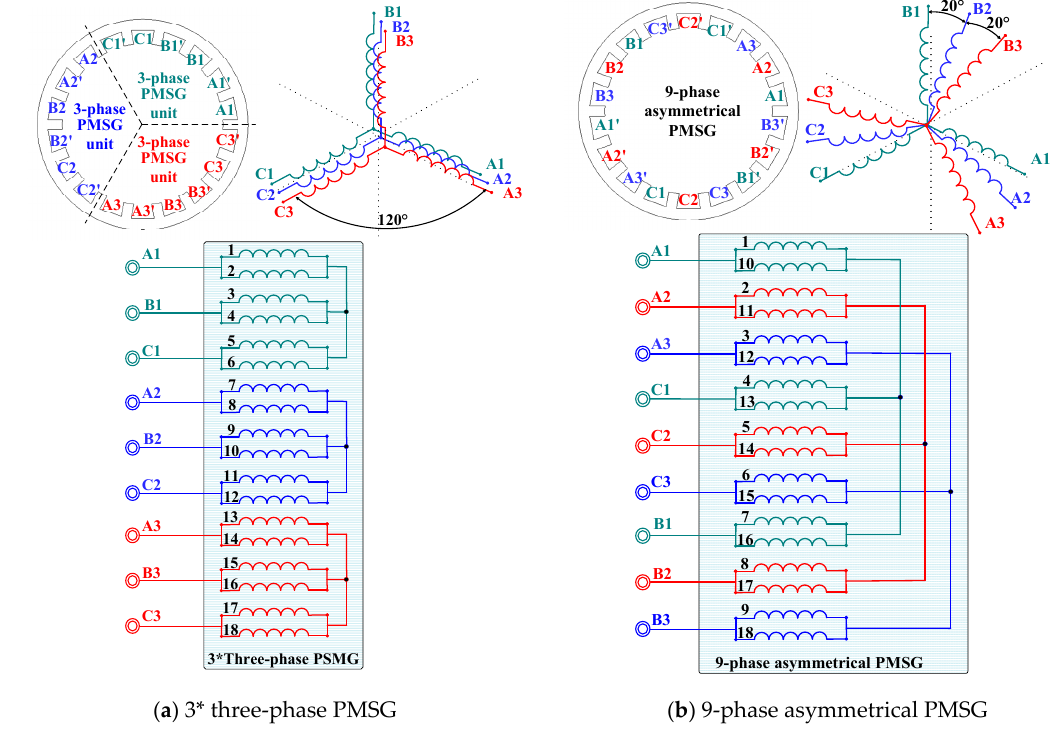
Figure 3. Vector and winding distribution diagram.